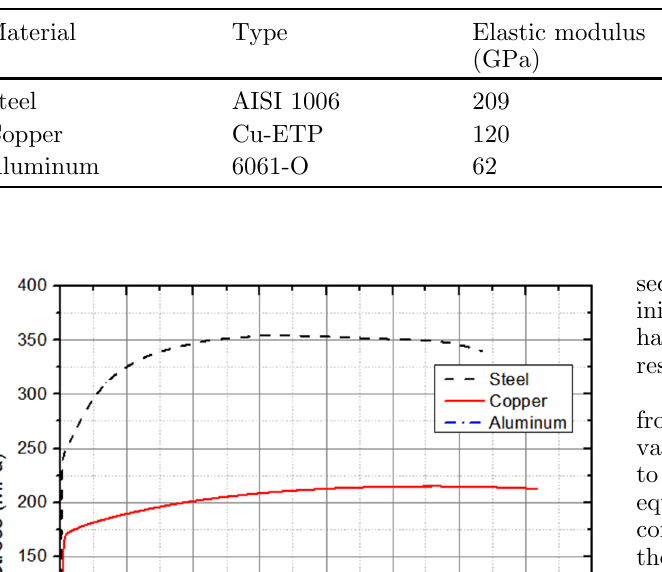
Table 1. Speci fi cations of blank